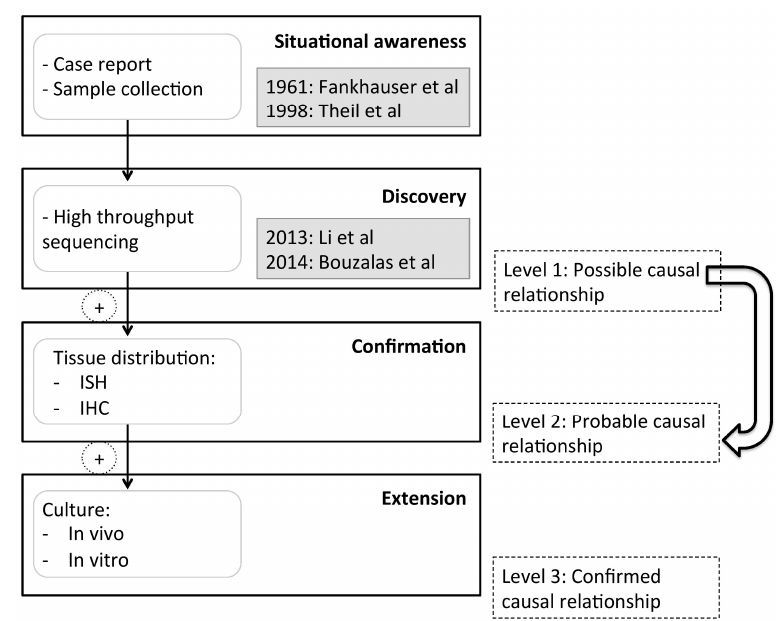
Figure 1. Assessment of causation of bovine astrovirus (BoAstV) CH13/NeuroS1 infection in non-suppurative bovine encephalitis (Figure adapted from: Lipkin and Anthony [18]). The first reports of non-suppurative encephalitis in cattle date back to 1961, but all studies aiming at identifying a possible agent have remained inconclusive [12–14]. After discovery of BoAstV CH13/NeuroS1 in such cases, the criteria for a “possible causal relationship” were met but not yet for a probable causal relationship due to limitations in the study design [6,7]. To confirm that the BoAstV CH13/NeuroS1 is a probable cause for bovine non-suppurative encephalitis, we investigated the statistical association of the virus and the disease, and compared the topography of virus infection to that of the histopathological brain